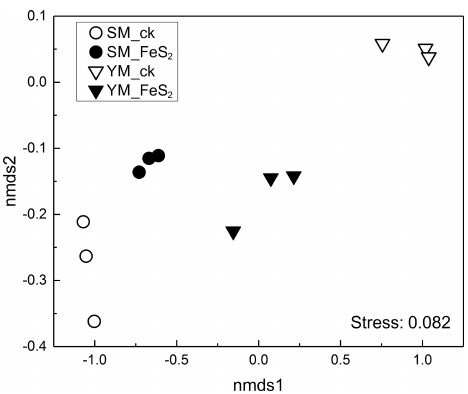
Figure 2. Nonmetric multidimensional scaling (NMDS) of the over- all bacterial community composition according to Bray–Curtis dis- tance matrices in mine